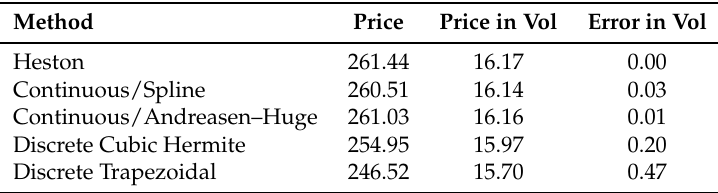
Table 6. Variance swap prices based on SPX500 options under the Heston model parameters from Table